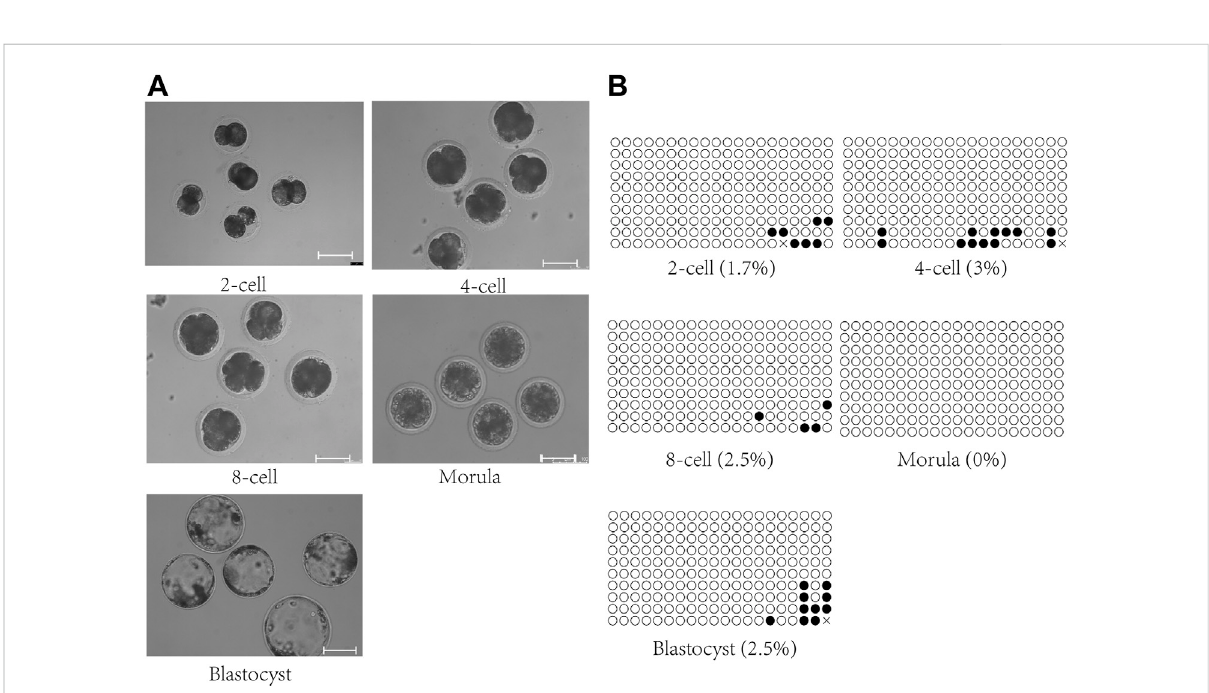
FIGURE 3 Methylation analysis of the IG-DMR in parthenogenetic embryos. (A) . Parthenogenetic embryos at different developmental stages. Scale bars, 100 μ m. (B) .Methylation analysis oftheIG-DMR inparthenogenetic embryos. Eachcircle represents aCpG dinucleotide.The degree ofmethylation (%) is based on methylated CPGs/all CPGs; open circles indicate unmethylated CpGs, and fi lled circles indicate methylated